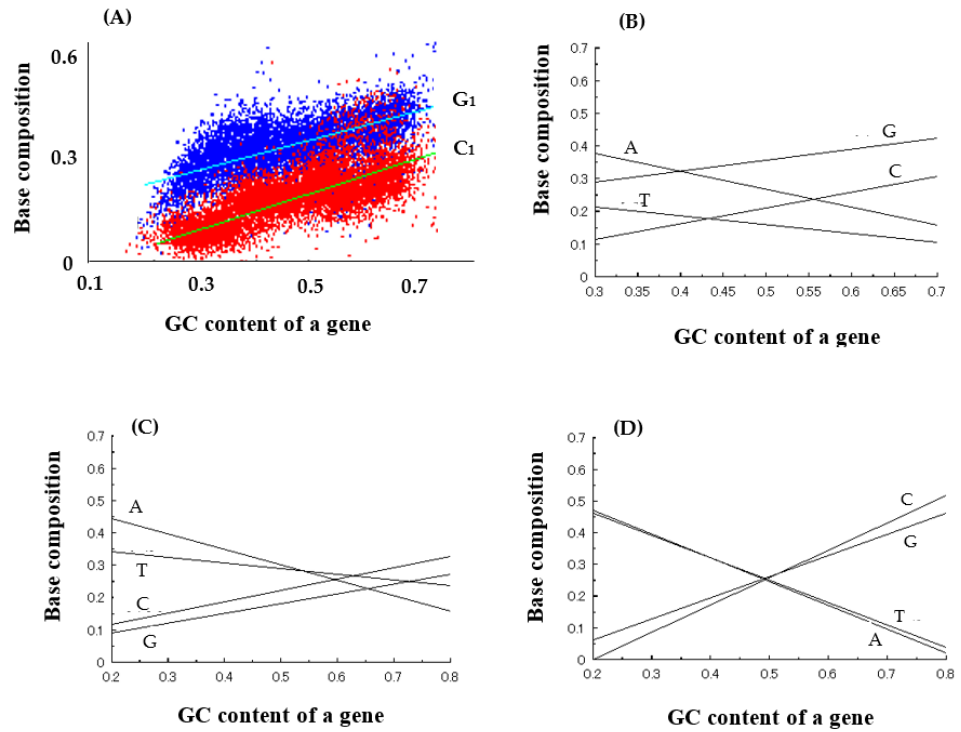
Figure 2. Average base composition of microbial genes. ( A ) Dependencies of G 1 and C 1 compositions at 1st codon position on GC content of a gene. ( B ) Dependencies of four base compositions (A, T, G, C) at 1st codon position on GC content of a gene. ( C ) Dependencies of four base compositions at 2nd codon position on GC content of a gene. ( D ) Dependencies of four base compositions at 3rd codon position on GC content of a gene. Note that the dependencies of base compositions on GC content are represented as straight lines approximated by the least-square method in (B – D).